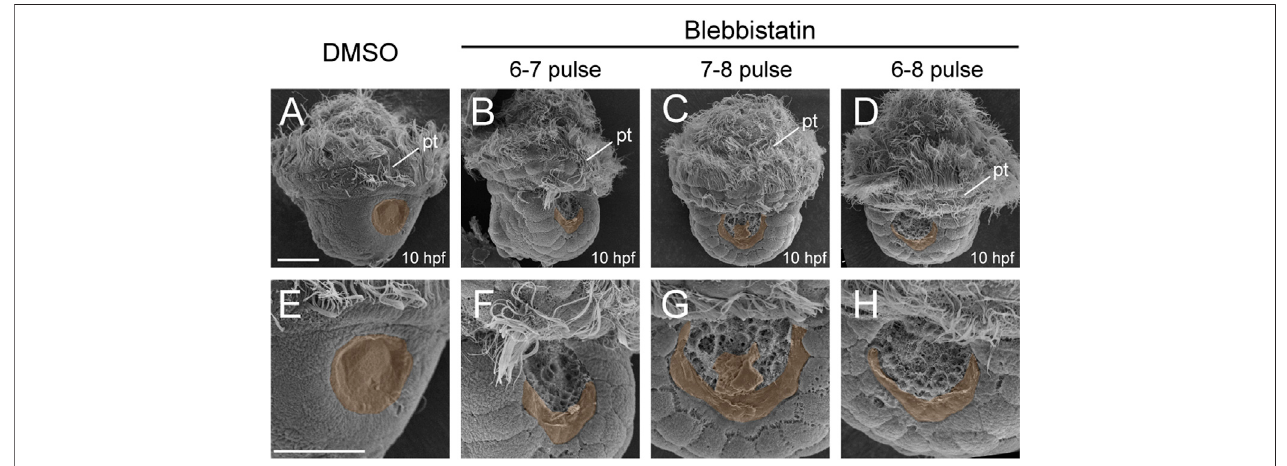
FIGURE 4 | Shell development at 10 hpf after blebbistatin treatments. All panels show SEM images, with dorsal views anterior to the top. Panels (E – H) show magni fi edimagestoviewthedetailsoftheshell fi eld.Thediscriminableshellplates[in (A) and (E) ]orshellpiecesduetomanipulations[in (B – D) and (F – H) ]arehighlighted with brown shadows. pt, prototroch. The bars represent 25 μ m.